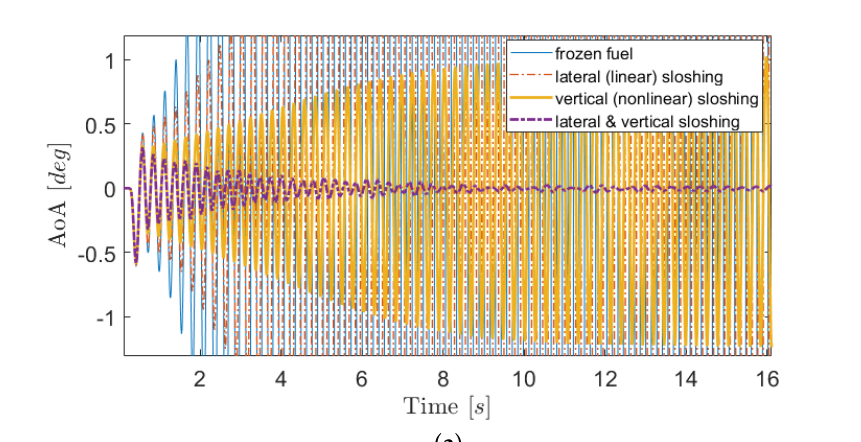
Figure 13. U ∞ = 21.1m/s and w g structural mode.